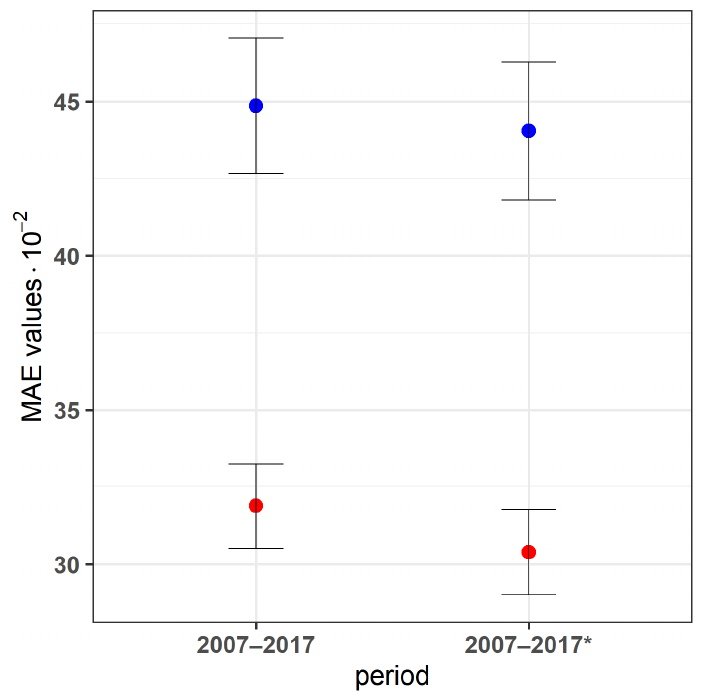
Figure 3. MAE values and MAE error bars for the 2007–2017 period. The asterisk means that the model was built on two selected variables (BOUFORIND and ROADLOC) and not based on the stepwise variables selection method. Note the units on the y -axis.